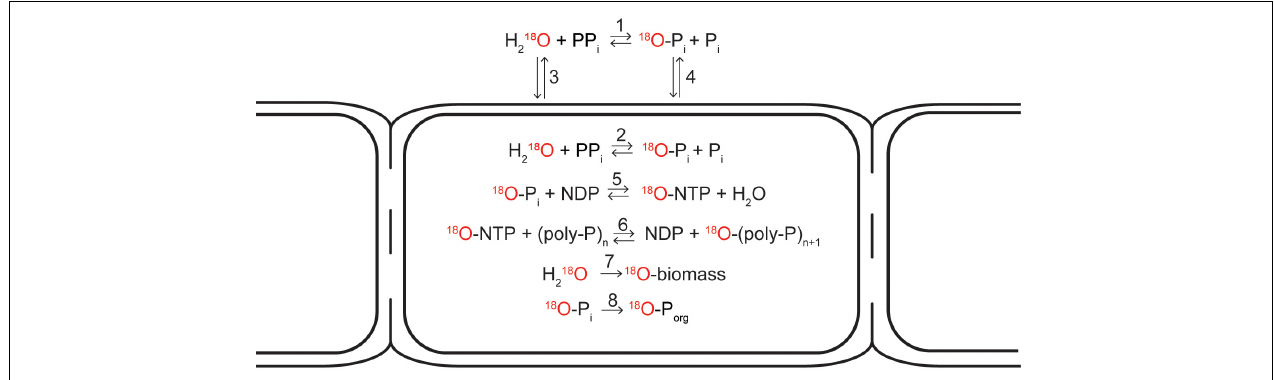
FIGURE 6 | Schematic diagram depicting possible pathways how the 18 O atom from an 18 O-labeled water molecule can end up in the cellular inorganic polyphosphate pool, cell biomass, and the organic phosphate pool. 18 O exchange between 18 O-labeled water and (ortho)phosphate (P i ) occurs when inorganic pyrophosphate (PP i ) is hydrolyzed. This process is catalyzed by enzymes and can occur both outside (1) and inside the cell (2). When occuring inside the cell, 18 O-labeled water is first transported into the cell via diffusion (3). When occuring outside the cell, the 18 O-labeled phosphate is transported inside the cell either actively (via membrane-bound transport proteins) or passively via diffusion (4). As soon as the 18 O-labeled phosphate is in the cytoplasm, it can be incorporated into a nucleoside triphosphate molecule (e.g., ATP) if energy is available (5), from which it can be added onto a polyphosphate chain (6). 18 O atoms from 18 O-labeled water can also be incorporated into cell biomass during cell growth (7). Additionally, 18 O-labeled phosphate can be incorporated into cellular organic phosphate pools such as DNA, RNA, or phospholipids (8). Modified from Blake et al. (2005).